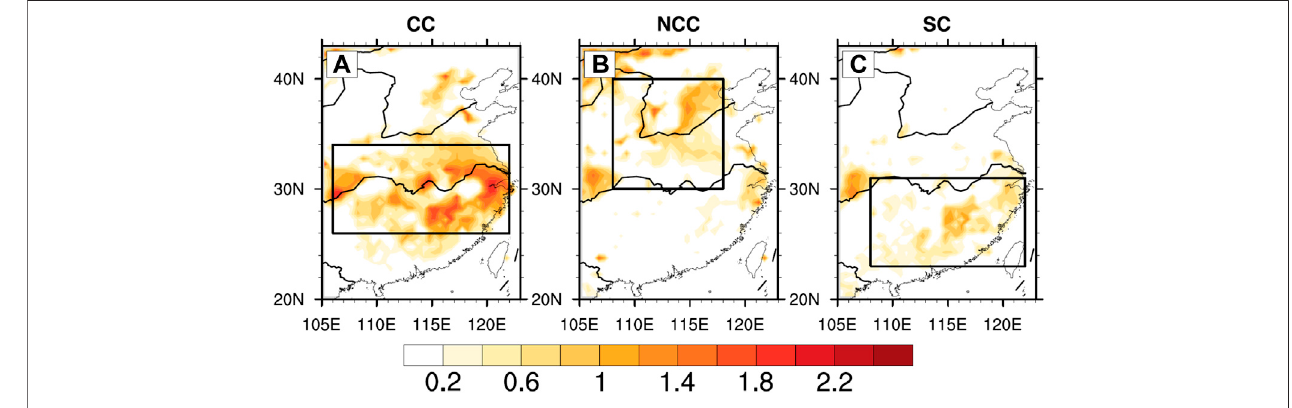
FIGURE 3 | Same as Figure 1 , but for HWI (unit: ° C per pentad).